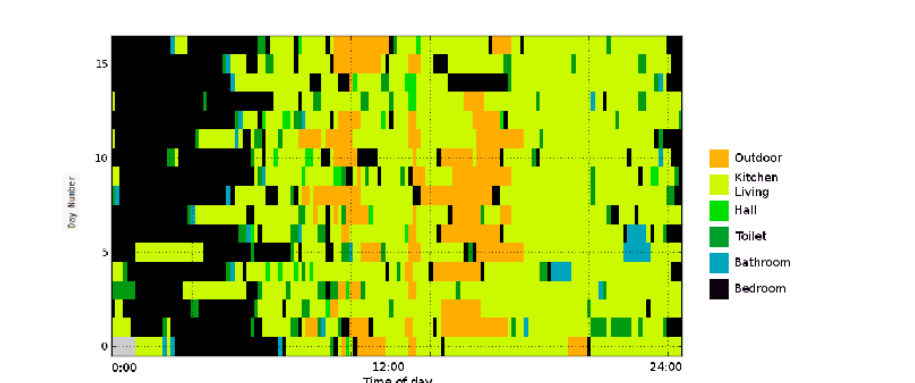
Figure 3. An example of a heat map illustrating several days of an individual’s locational history over the course of a day. For visualization purposes, each day is divided into 48 30-min slots (in reality, time slots would be for instance 60 s). Each color represents a different location.